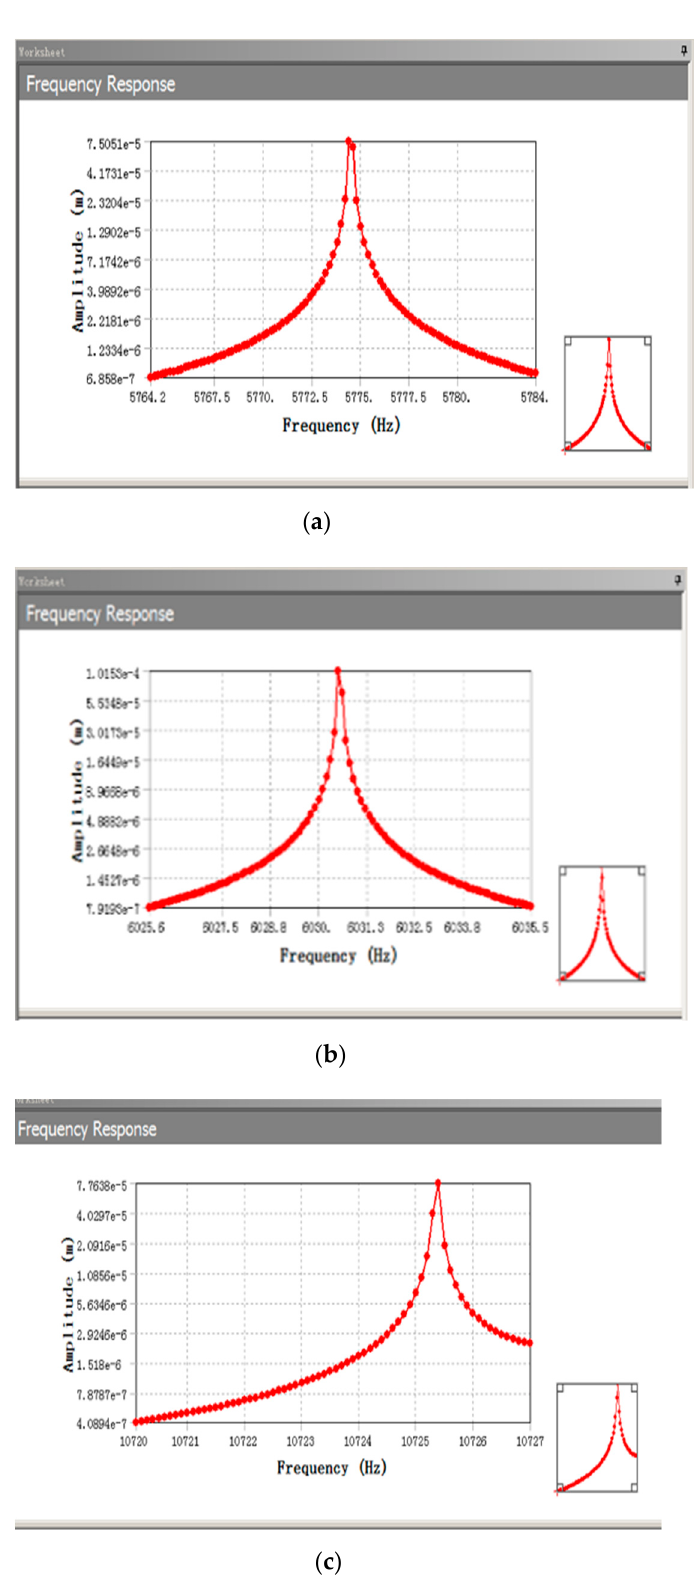
Figure 13. Harmonic response analysis: ( a ) X-axis sensing harmonic response; ( b ) Y-axis sensing harmonic response; ( c ) Z-axis sensing harmonic response.